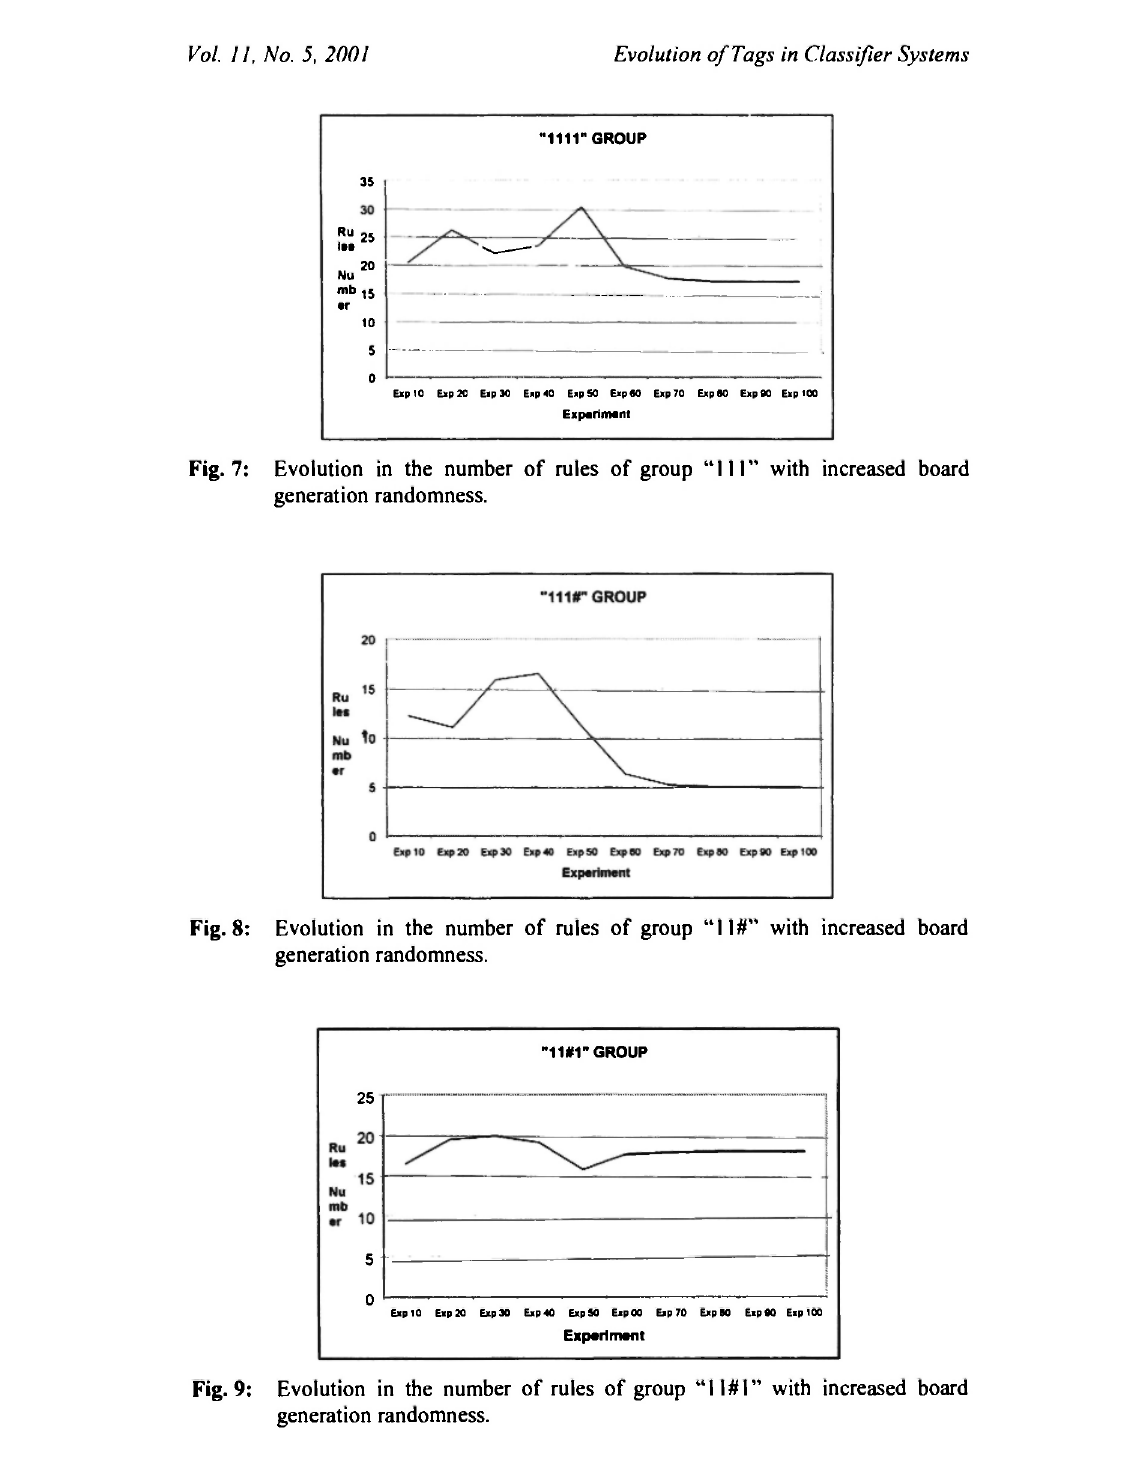
Fig. 9: Evolution in the number of rules of group "ll#l" with increased board generation